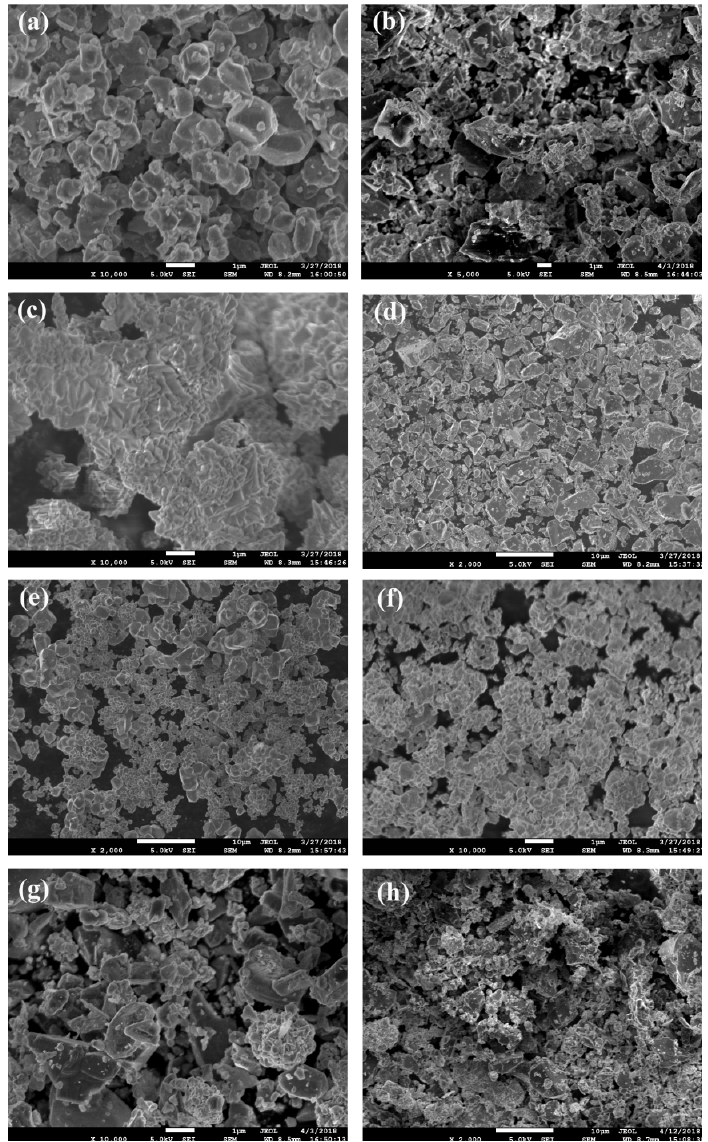
Figure 1. SEM of powders: ( a ) TiC; ( b ) TiN; ( c ) Ni; ( d ) Co; ( e ) Mo; ( f ) WC; ( j ) Cr 3 C 2 ; ( h ) C.